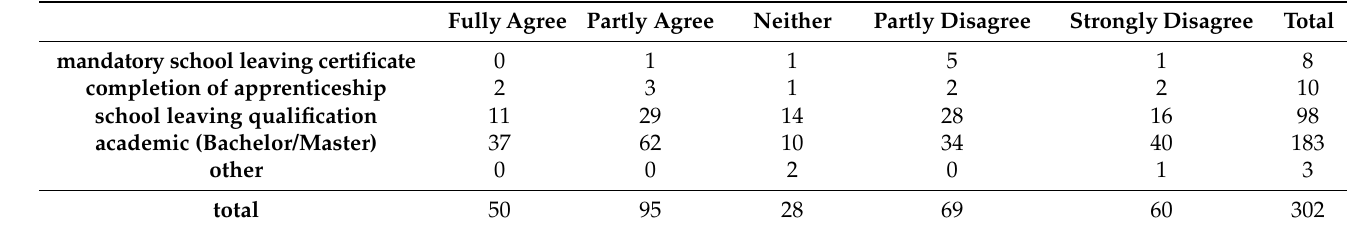
Table 1. School education and interest in financial products.